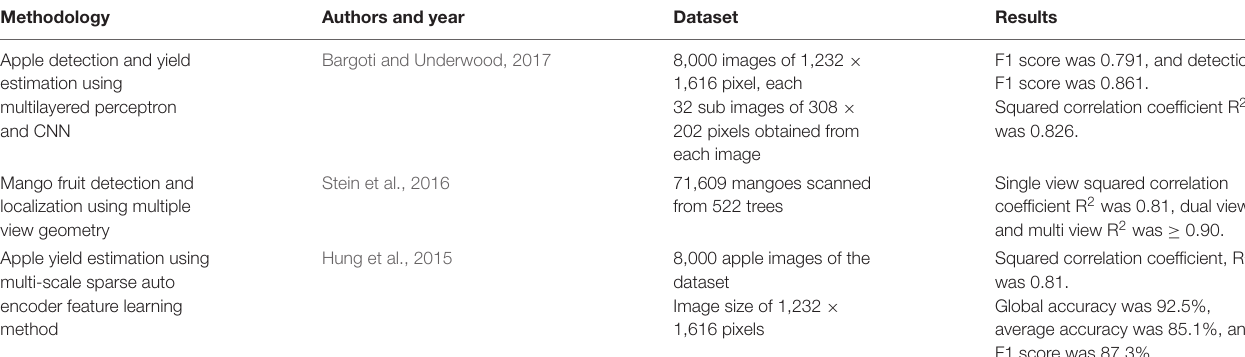
TABLE 3 | CNN with pixel-based prediction